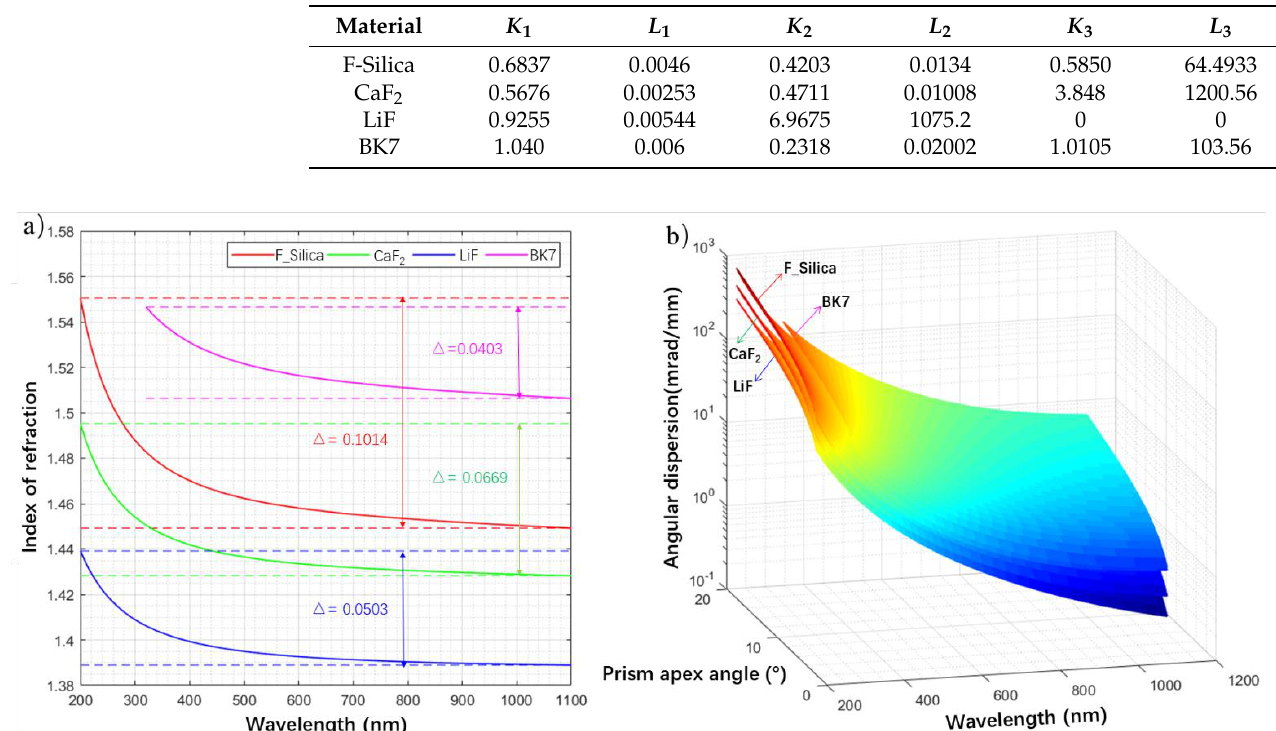
Table 2. Sellmeier formula constants for common prism materials.